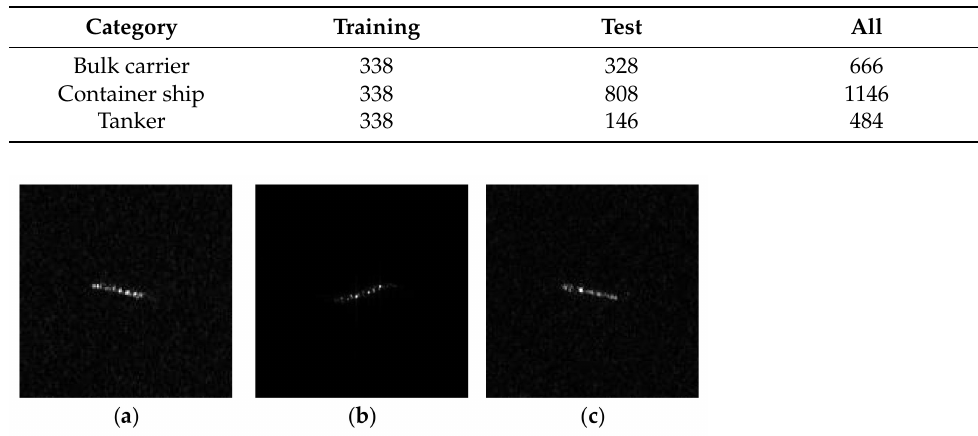
Figure 20. Three-category SAR ship images in the OpenSARShip-1.0 dataset. ( a ) Bulk carrier; ( b ) container ship; ( c )